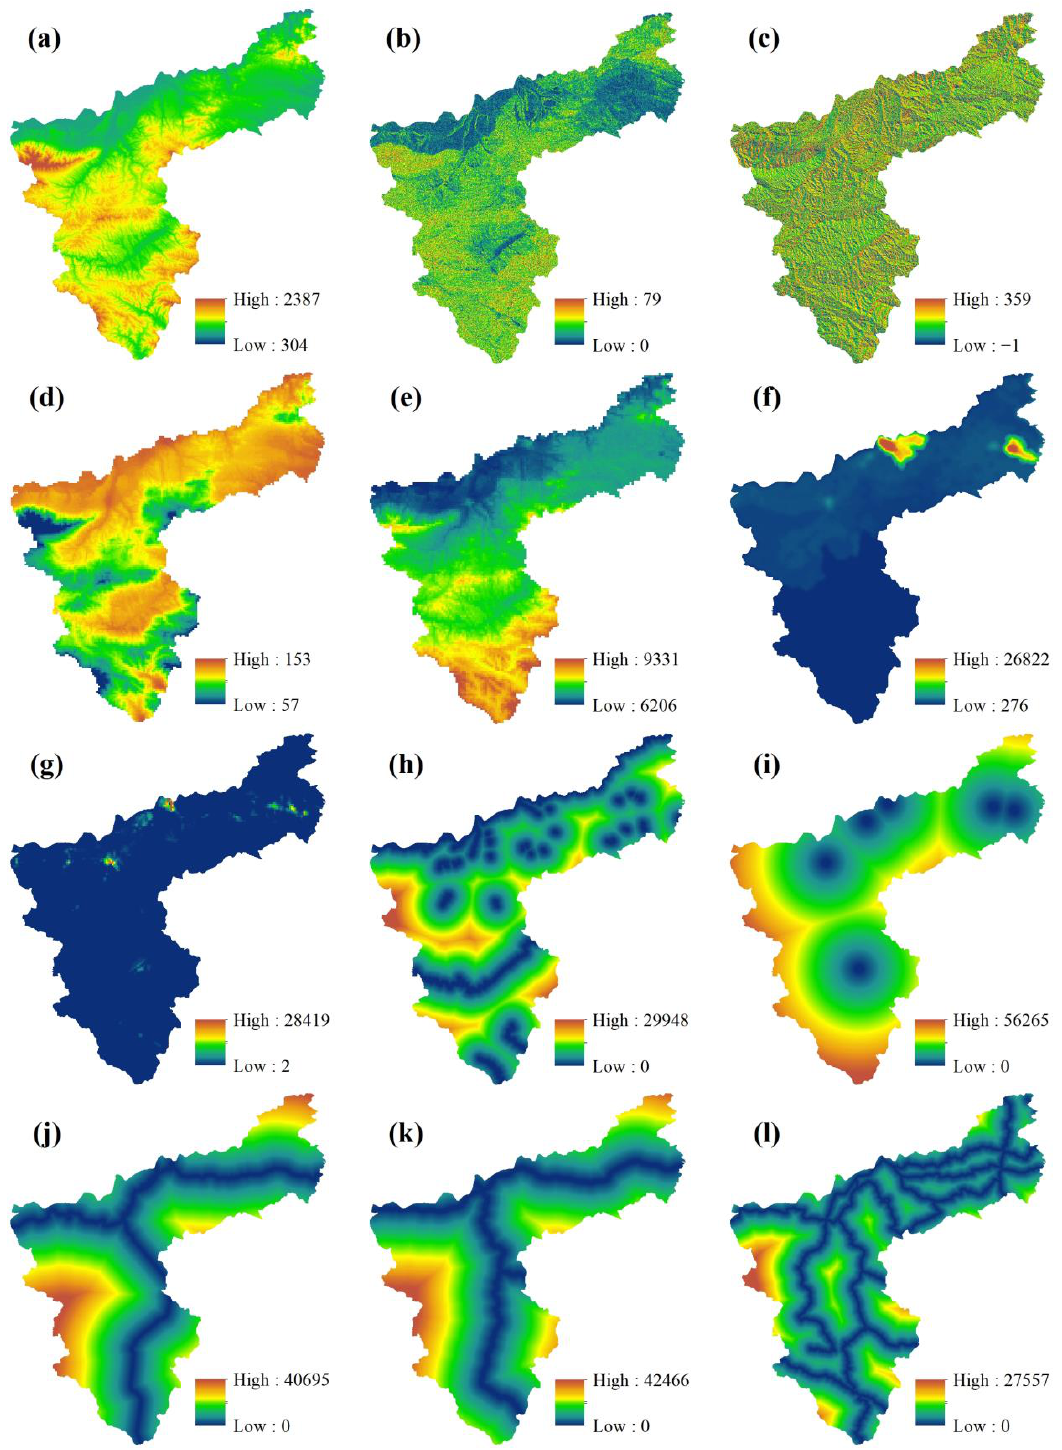
Figure 3. The main driving factors of land use change in Sanmenxia (( a ), DEM; ( b ), slope; ( c ), aspect; ( d ), temperature; ( e ), amount of precipitation; ( f ), GDP; ( g ), population density; ( h ), distance to river; ( i ), distance to administrative center; ( j ), distance to railway; ( k ), distance to highways; ( l ), distance to road).